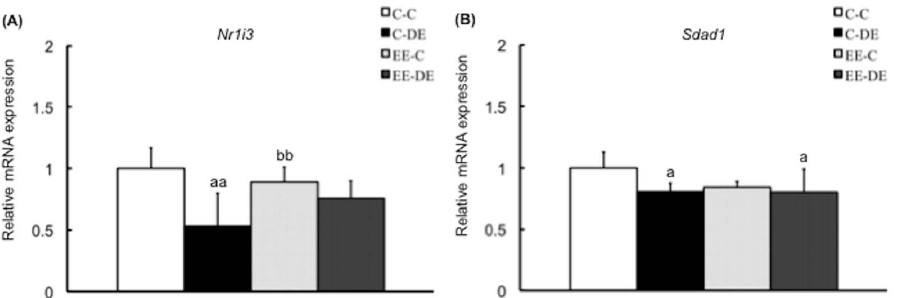
Figure 6. Confirmation of microarray data in cluster C by RT-PCR. Data show mRNA expressions for (A) Nr1i3 , and (B) Sdad1 in the olfactory bulb of mice in each group. Nr1i3 and Sdad1 of the olfactory bulb of mice reared in a standard cage environment were significantly downregulated by exposure to diesel exhaust. There was no significant effect of exposure to diesel exhaust on gene expressions of mice reared in environmental enrichment. The data are expressed as relative target gene expression compared with Gapdh expression. Each column represents the mean 6 standard deviation (C-C: n=7, C-DE: n=7, EE-C: n=8, EE-DE: n=9). Data were analyzed by two-way analysis of variance as described in the Methods section. An analysis of simple effects is as follows: Nr1i3 : a indicates significant differences (Tukey–Kramer method, aa P , 0.01, C-C vs. C-DE); b indicates significant differences (Tukey–Kramer method, bb P , 0.01, C-DE vs. EE-C); and Sdad1 : a indicates significant differences (Tukey–Kramer method, a P , 0.05, C-C vs. C-DE and C-C vs.